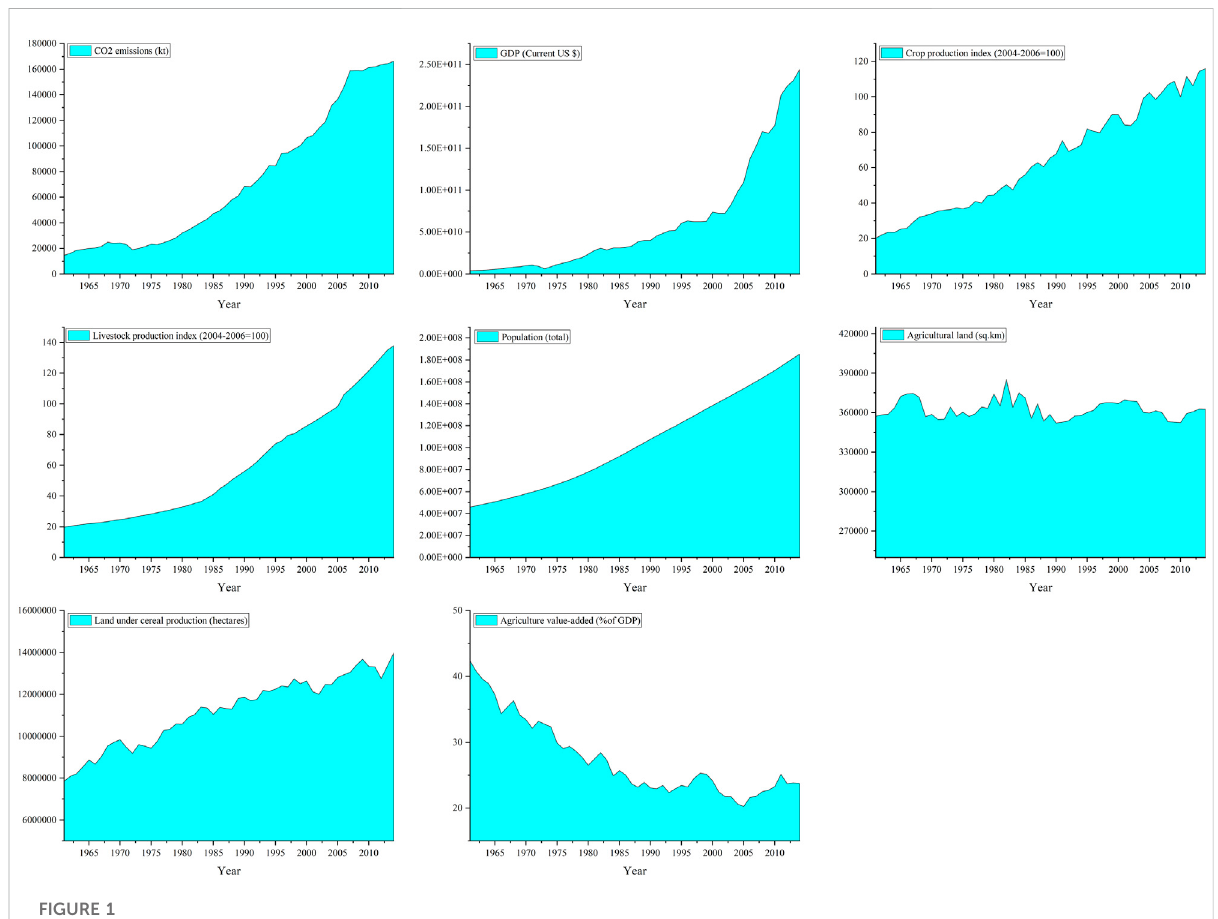
FIGURE 1 All individual graphs for dataset